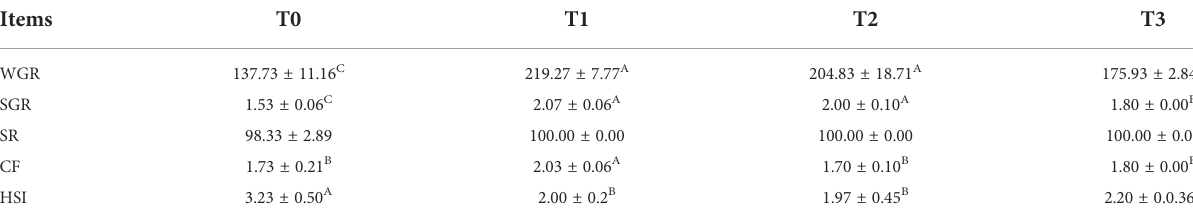
TABLE 4 Growth performance and morphological